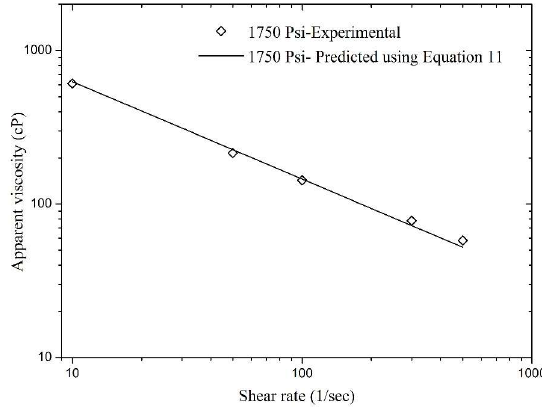
Figure 13. Validation of Equation (11) with experimental data of apparent viscosity obtained 1750 Psi. Table 4. Parametric estimates of the sCO 2 foam viscosity model (Equation (11)). Parameter Estimates